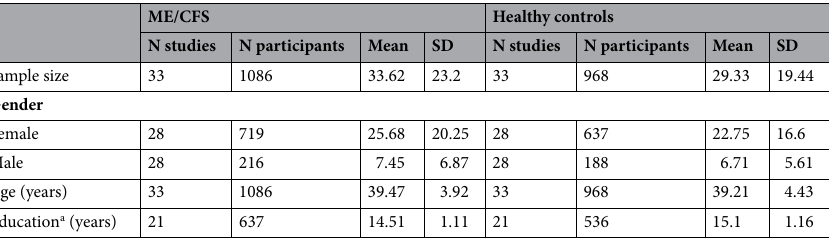
Table 1. Descriptive statistics for the study participants. ME/CFS myalgic encephalomyelitis/chronic fatigue syndrome, N number. a Number of education years from age